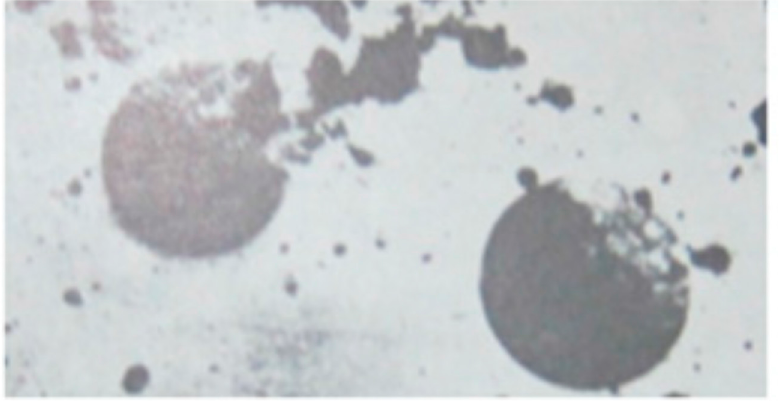
Figure 3. Goodspeed’s first shadowgraph produced in the University of Pennsylvania on 20 February 1890. The rounded shadows are coins. (Taken from: The Trail of the Invisible Light ).